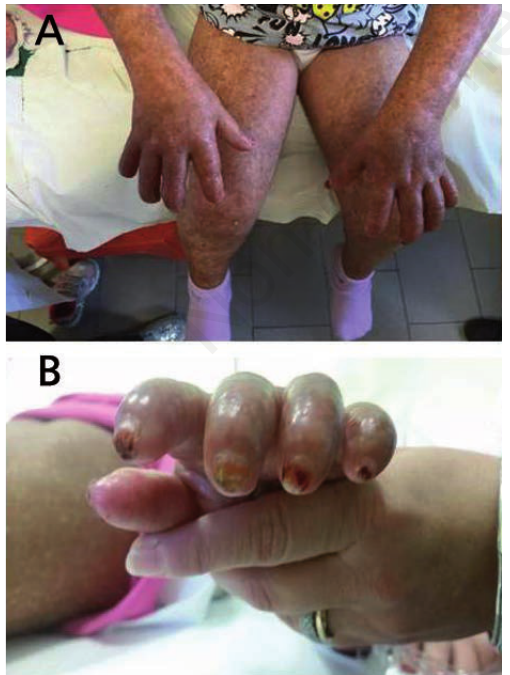
Figura 1. Tra le caratterische principali della Sindrome di Clericuzio la poichilodermia e la pachionichia, che può asso- ciarsi a delle vere e proprie amputazioni come nella nostra paziente